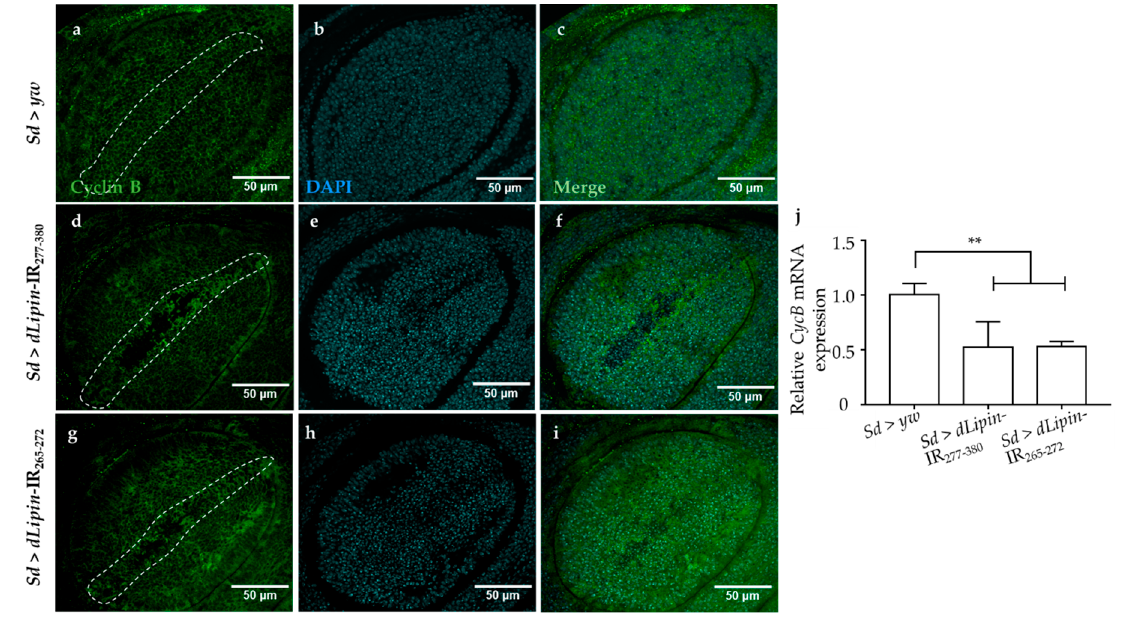
Figure 5. Induction of dLipin RNAi leads to reduced expression of the cyclin B in the wing margin area of wing imaginal discs. The wing imaginal discs were stained with DAPI to visualize the DNA ( b, e, h ) and mouse anti-cyclin B antibody followed by anti-mouse IgG Alexa Fluor TM 488 antibody ( a, d, g ). Merged images of DAPI and anti-cyclin B antibody ( c, f, i). CycB mRNA levels in wing imaginal discs of 3rd-instar larvae of control and dLipin -kd flies were analyzed by RT-qPCR ( n = 5 for each genotype). The relative dLipin mRNA level of dLipin -kd flies to that of control flies is shown ( j ). Data are expressed as the means ± S.D. The statistical significance of the difference between control and dLipin -kd flies was evaluated using one-way ANOVA. **, p < 0.02. The dotted lines indicate the margins of wing imaginal discs. Scale bar, 50 µm; IR, inverted repeat. Genotypes: Sd -GAL4/+; +; + ( a – c ), Sd -GAL4/+; UAS -dLipin- IR 277-380 /+; + ( d – f ), Sd -GAL4/+; UAS -dLipin- IR 265-272 /+; + ( g – i ).